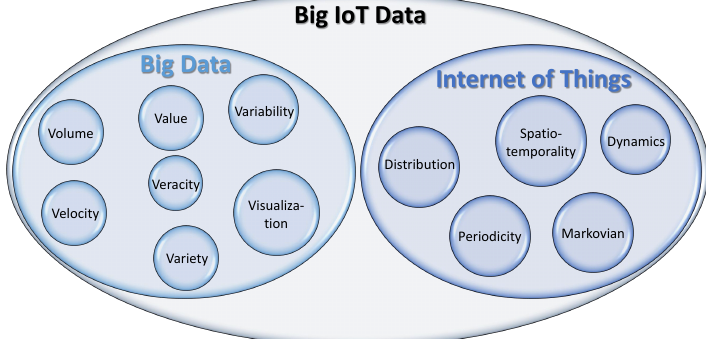
Figure 4. Big IoT data’s characteristics.